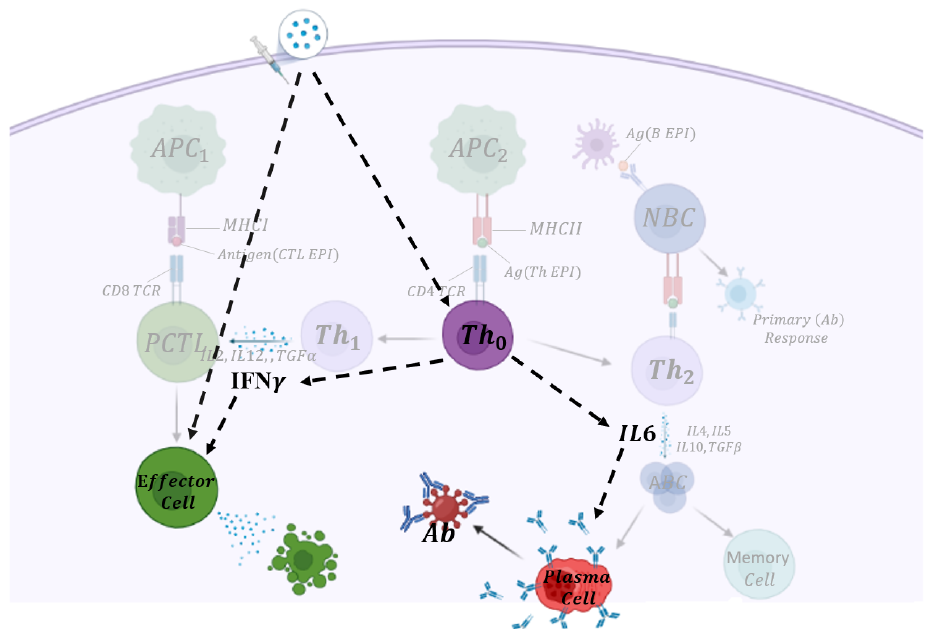
Figure 1. Vaccine-induced immune activation pathway for an adenovirus vaccine. Faint background: The subsequent downstream of signaling pathways activated through adaptive immunity when SARS-CoV-2 enters the human cell. Highlighted compartments describe vector-based vaccine- induced immune system stimulation that is modeled explicitly in this study. The dashed arrows show implicit communications between cells and cytokines, and the only solid arrow indicates the production of antibodies by